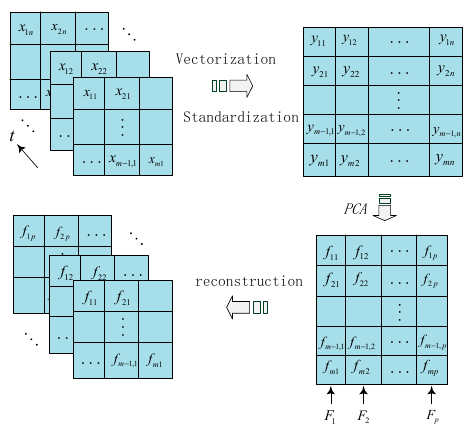
Figure 3. Process of